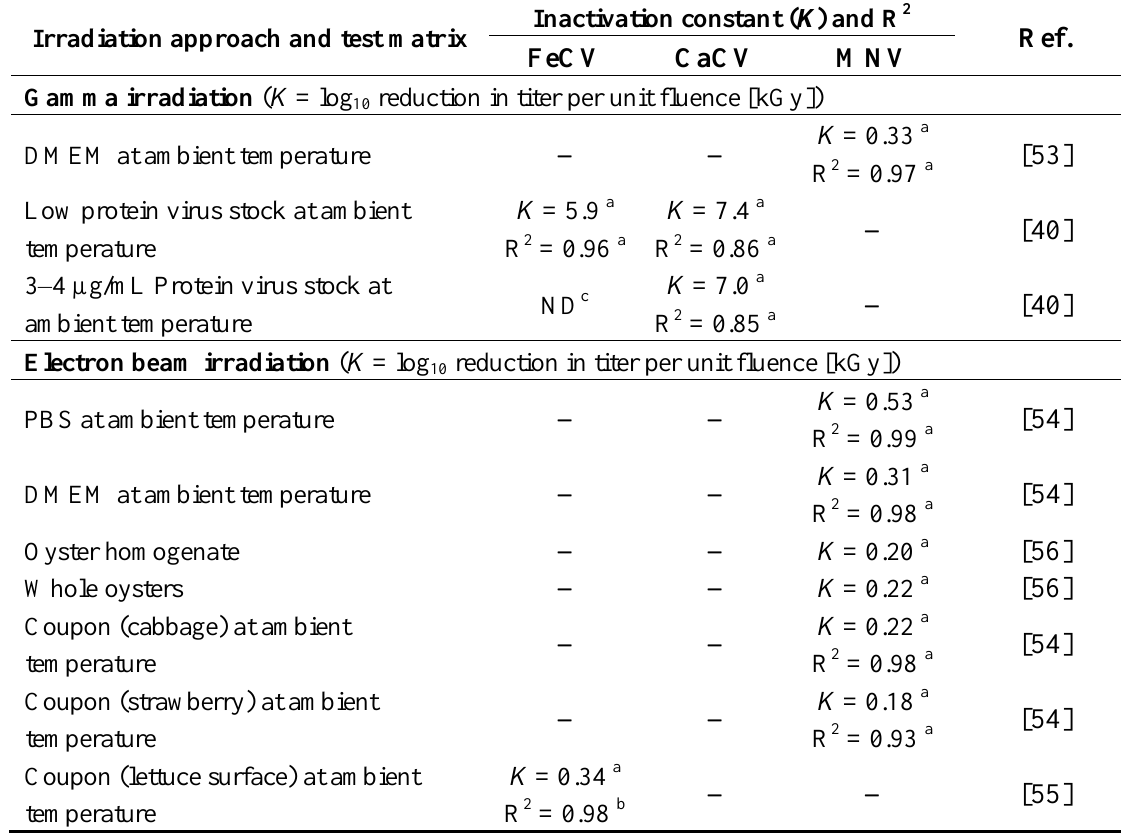
Table 4. Inactivation constants for ionizing